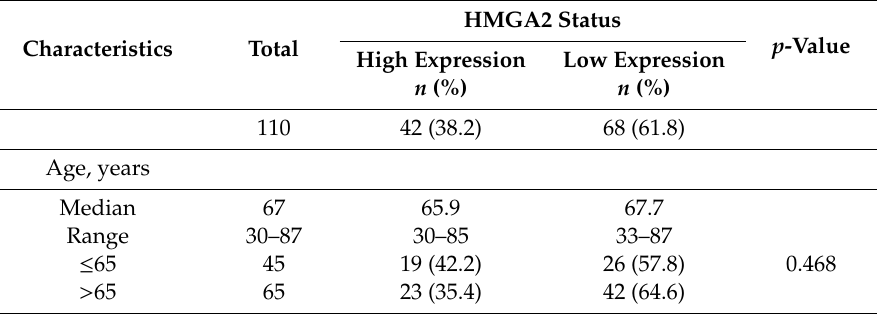
Table 1. Correlation between HMGA2 expression and clinicopathological factors in 110 oral squamous cell carcinoma (OSCC) patients.